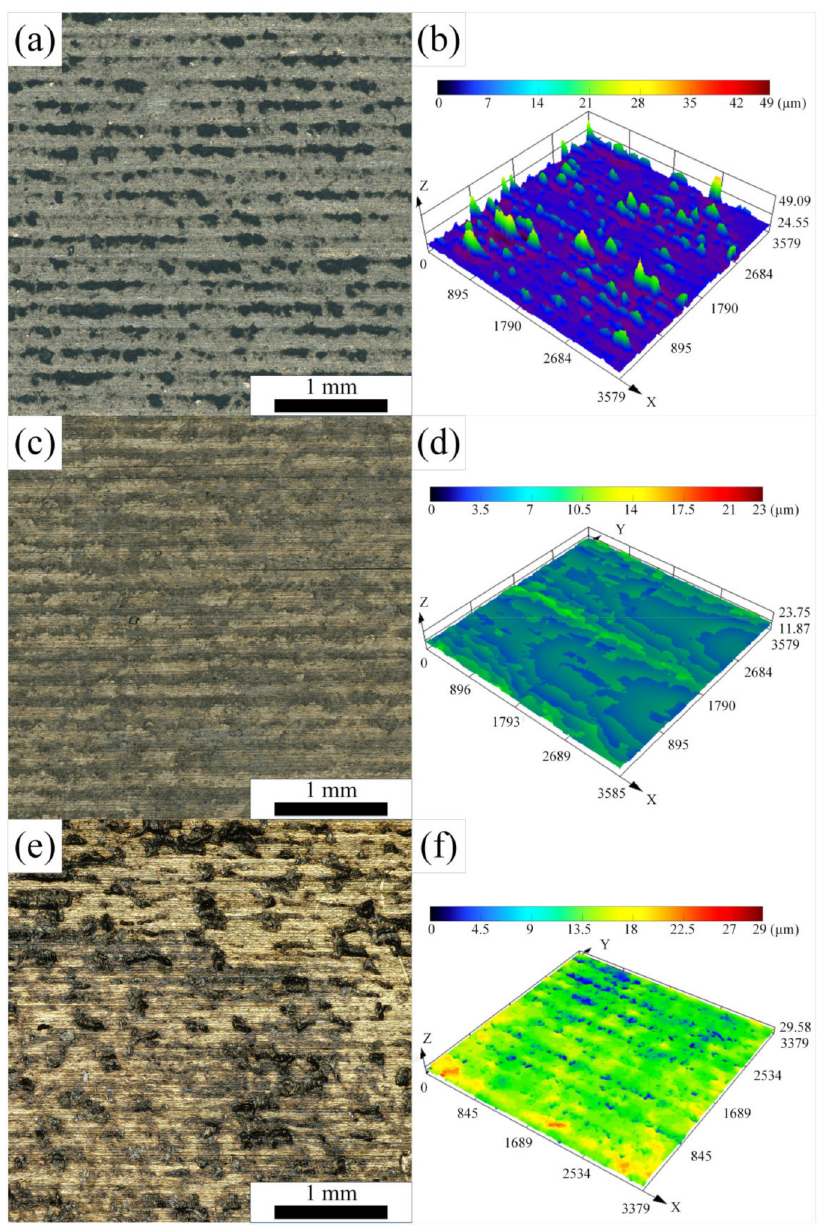
Figure 10. Effect of the spot overlap ratio of water jet-guided laser on the surface morphology of samples. ( a ) γ 1 = 70%, γ 2 = 70%; ( b ) γ 1 = 70%, γ 2 = 70%; ( c ) γ 1 = 70%, γ 2 = 80%; ( d ) γ 1 = 70%, γ 2 = 80%; ( e ) γ 1 = 80%, γ 2 = 80%; ( f ) γ 1 = 80%, γ 2 =